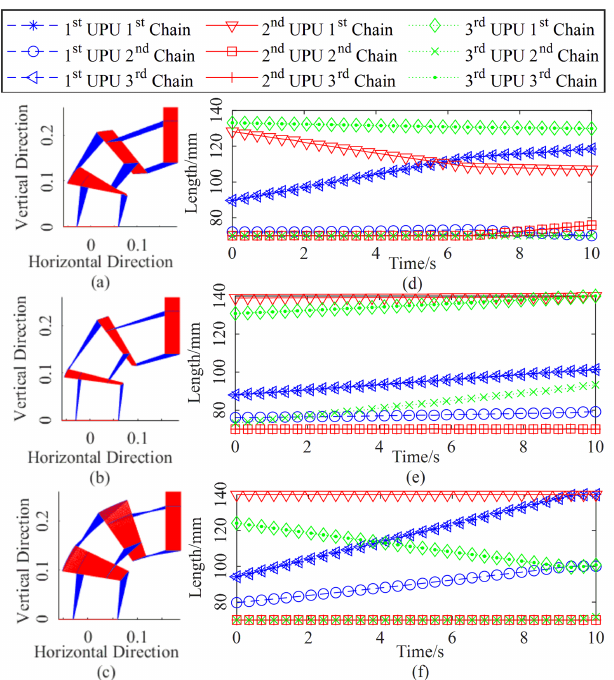
Figure 5. Configurations and prismatic joint lengths of the robot. ( a – c ) represent robot configurations along a given end-effector trajectory, and ( d – f ) represent the actuating prismatic joint lengths corresponding to configurations ( a – c ), where ( a , d ) show the results for a random configuration, ( b , e ) for another random configuration, ( c , f ) for the optimized configuration.